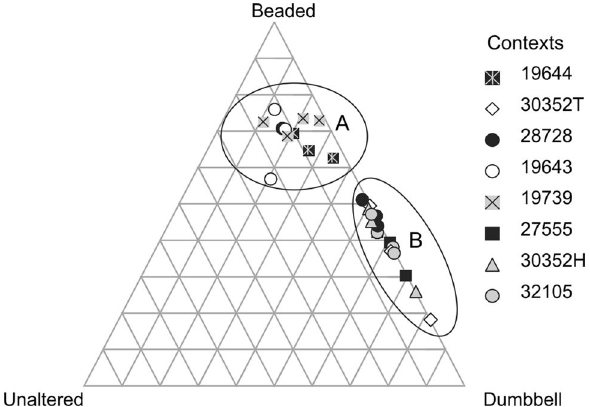
Figure 2. Ternary plot from Koon et al. 17 . The clusters demonstrate uncooked ( A ) and cooked ( B ) bones